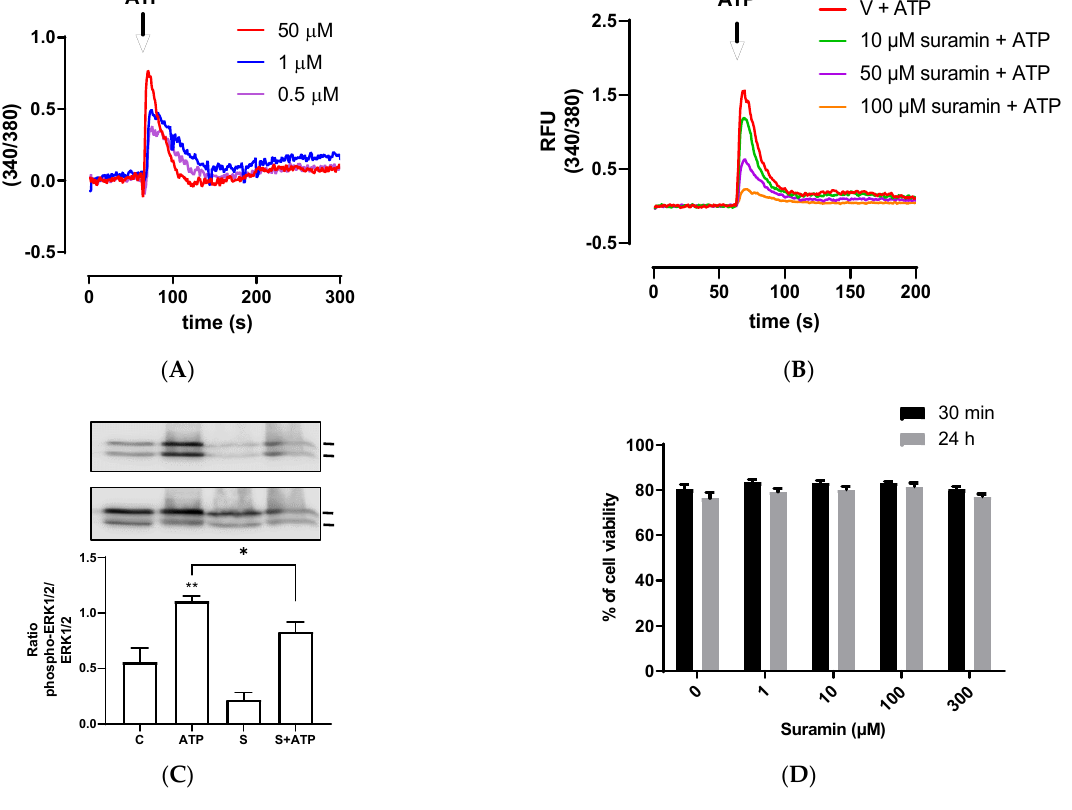
Figure 2. ATP increases intracellular calcium mobilization and ERK1/2 phosphorylation. ( A ) Fura 2AM-loaded BEND cells were treated with vehicle (PBS) and basal fluorescence was registered for 60 s; then, different concentrations of ATP (0.1, 1, or 50 µ M) were added and the fluorescence was determined for 240 s. RFU = relative fluorescence units. ( B ) Fura 2AM-loaded BEND cells were incubated with vehicle (0.1% DMSO) or suramin (10, 50, or 100 µ M) for 15 min. Then, the basal fluorescence was registered for 60 s and ATP (50 µ M) was added, and the fluorescence registered for 140 s. V = vehicle. ( C ) BEND cells were incubated with vehicle (0.1% DMSO) or suramin (50 µ M) for 15 min, and then vehicle (PBS) or ATP (50 µ M) was added, and incubation was carried out for 5 min. Total proteins were analyzed by immunoblot with antibodies against phospho-ERK1/2 and total ERK1/2. c = control (0.1% DMSO). S = Suramin. Bands’ intensities are shown as the ratio phospho-ERK1/2/ERK1/2 in the bar graph. ( D ) BEND cells were incubated with vehicle